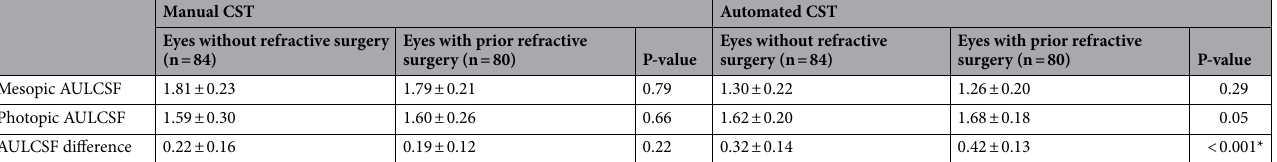
Table 3. Comparison of mesopic AULCSF, photopic AULCSF, AULCSF difference in patients with or without history of refractive surgery. AULCSF difference was calculated as Photopic AULCSF − Mesopic